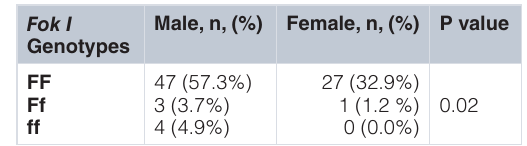
Table 3. Genotypes of fok I based on